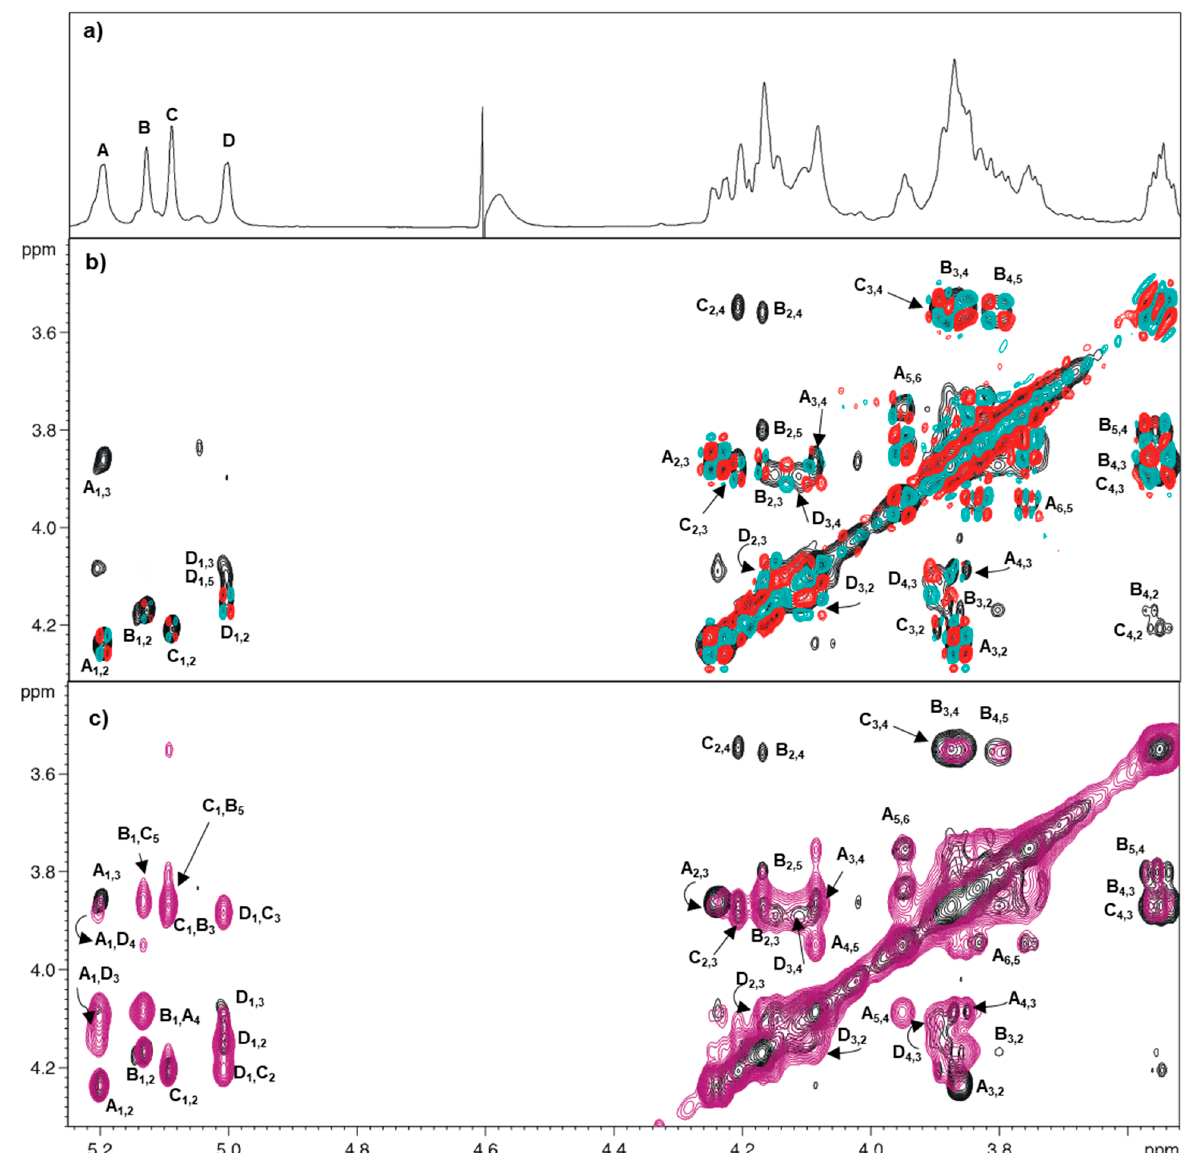
Figure 2. 1 H ‐ 1 H Homonuclear spectra of O ‐ antigen of C. metallidurans CH34. ( a ) proton spectrum; ( b ) overlay of TOCSY (black) and COSY (red and cyan) spectra; ( c ) overlay of TOCSY (black) and NOESY (violet) spectra. Letters used for the annotation of the densities follow the system of Table 1.